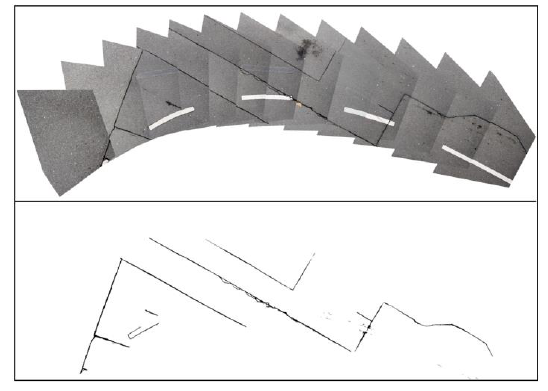
Figure 9. A stream of geocoded mobile images (top) with respective mosaicked crack images (bottom)